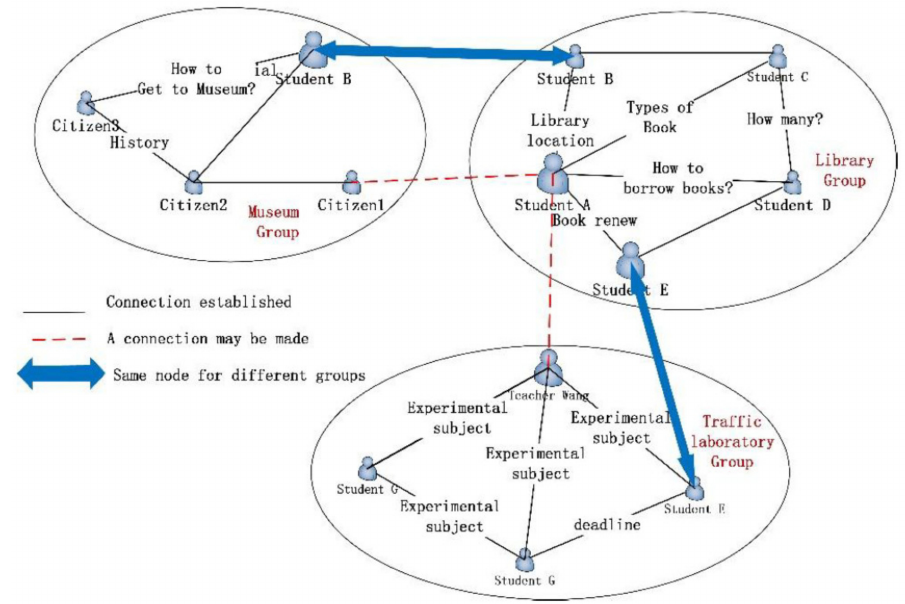
Figure 1. Characters’ social network.